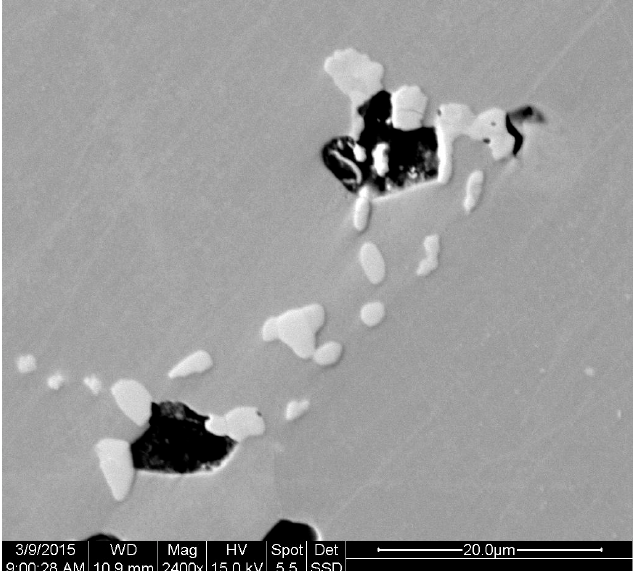
Figure 6. Creep voids are often nucleated in-between particles.